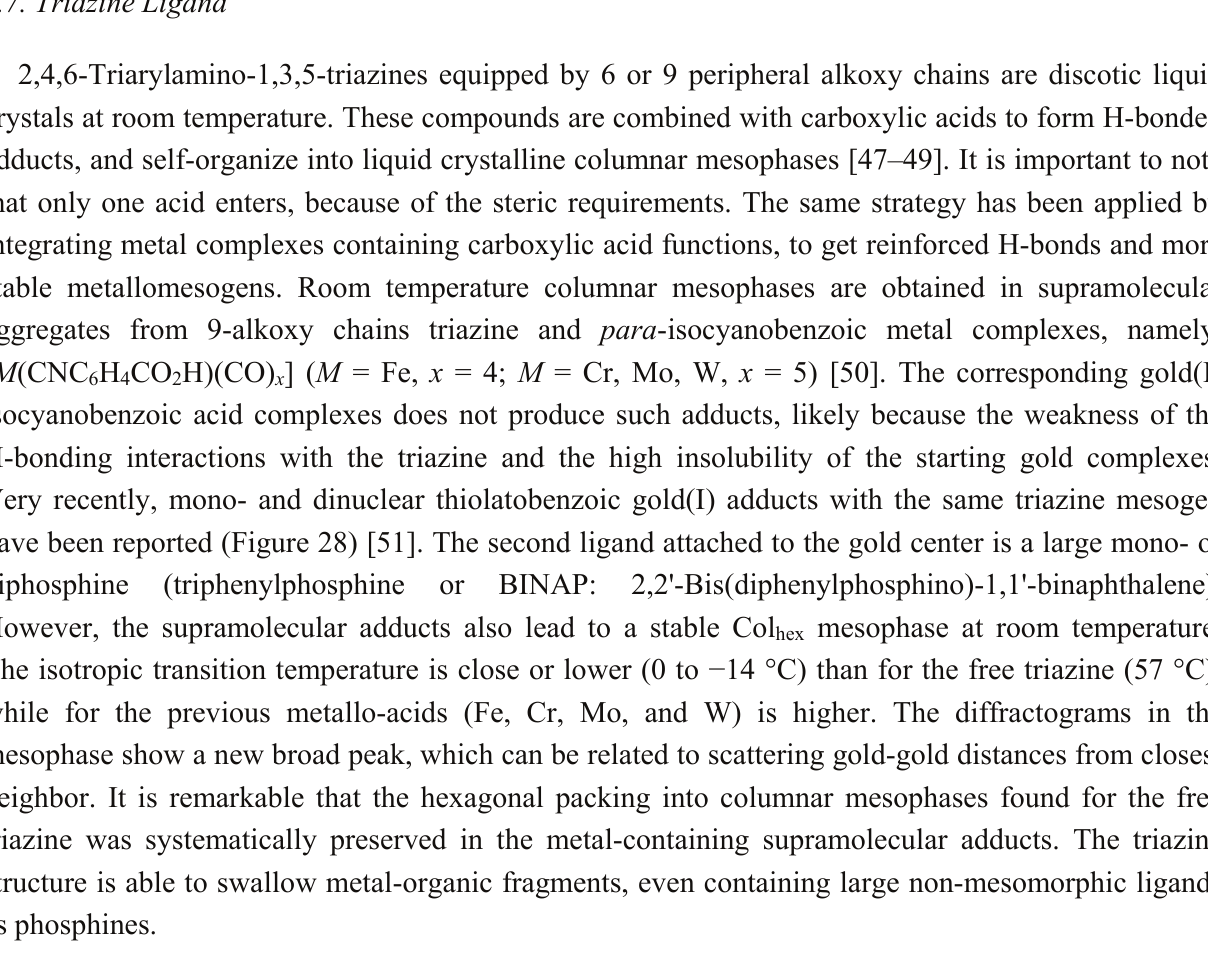
Figure 27. Supramolecular H-bond adducts. R = C